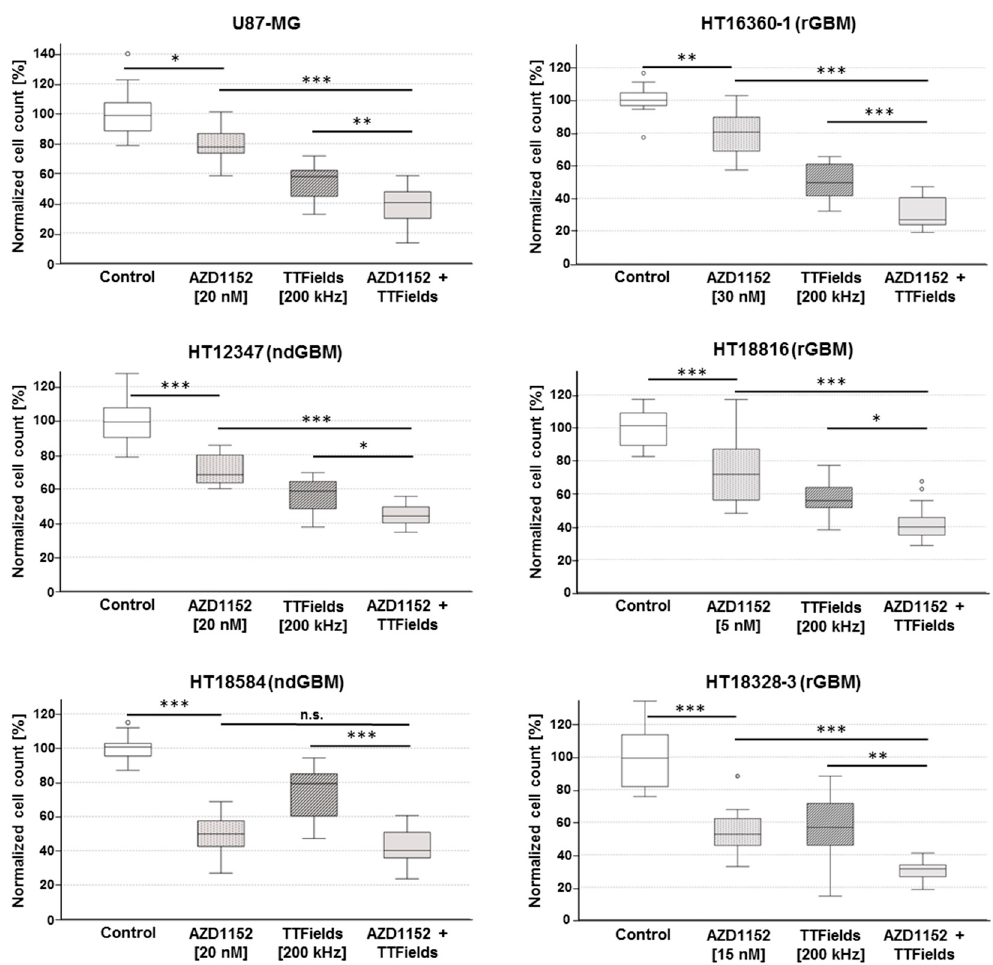
Figure 3. Cytotoxic effect of concomitant treatment. AZD1152 plus TTFields increase cell death. Boxplots show cell counts of U87-MG and primary glioblastoma cultures normalized to control after treatment with AZD1152 alone, TTFields alone, and the concomitant use of AZD1152 and TTFields for 72 h. Data represent median, minimum, maximum, first quartile, third quartile and ° outlier (N ≥ 12). * p < 0.05, ** p < 0.01, *** p < 0.001.